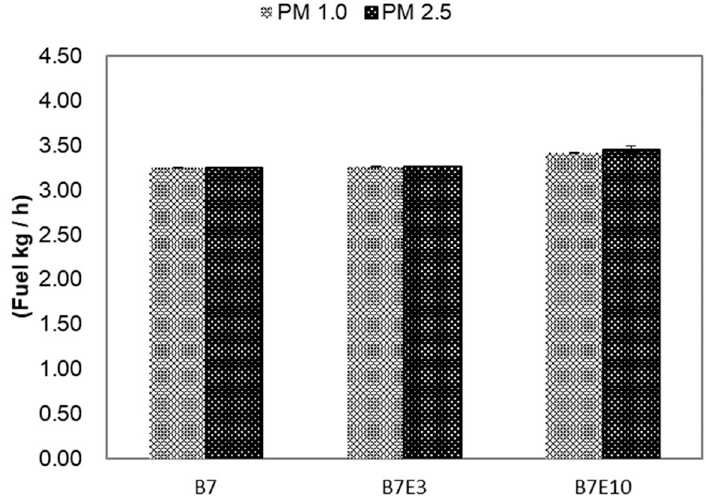
Figure 2. Fuel consumption B7, B7E3 and